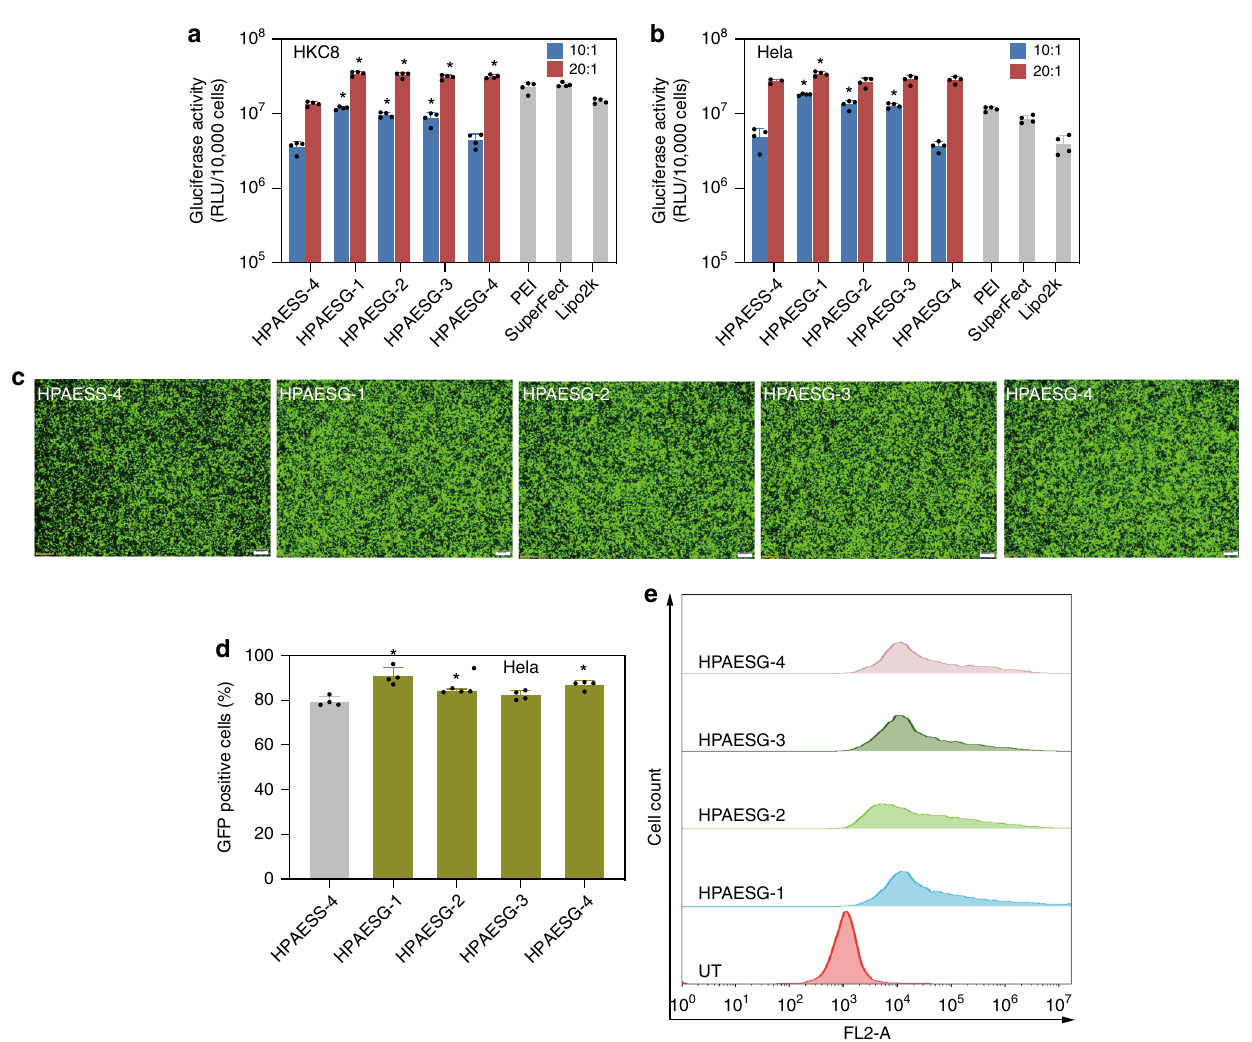
Fig. 7 The functionalization of HPAESS-4 with guanidine further improves transfection capability. a , b Gluciferase activity of HKC8 and HeLa cells after transfection with different vectors. Data points marked with asterisks (*) are statistically signi fi cantly higher relative to the HPAESS-4 group. c Fluorescence images of HeLa cells 48h post transfection with various vectors at w / w ratios of 20:1. The scale bars represent 200 μ m. d The percentage of GFP-positive cells after transfection, asterisk indicates signi fi cantly higher transfection ef fi ciency in comparison with the HPAESS-4 group. e Representative histogram distributions of UT HeLa cells and the ones after transfection with HPAESGs at the w / w = 20:1. Data are shown as average ±SD; n =